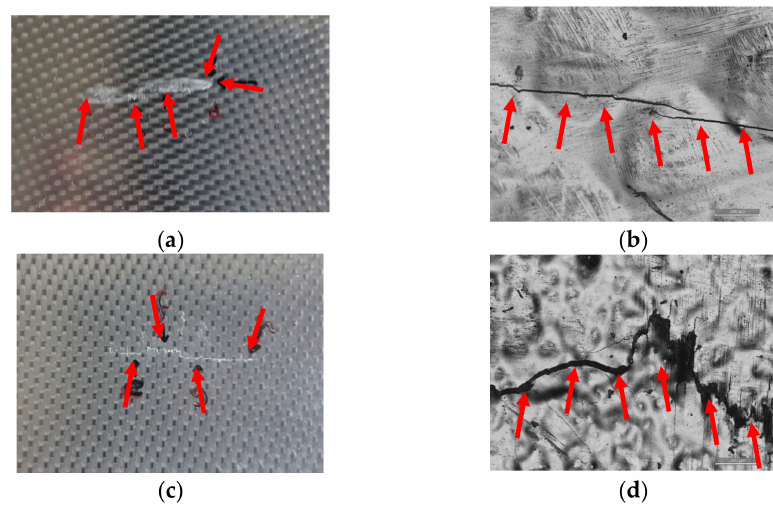
Figure 18. Microscopic images of panel 18: ( a ) front face, ( b ) magnification of the front face, ( c ) back face, and ( d ) magnification of the back face.